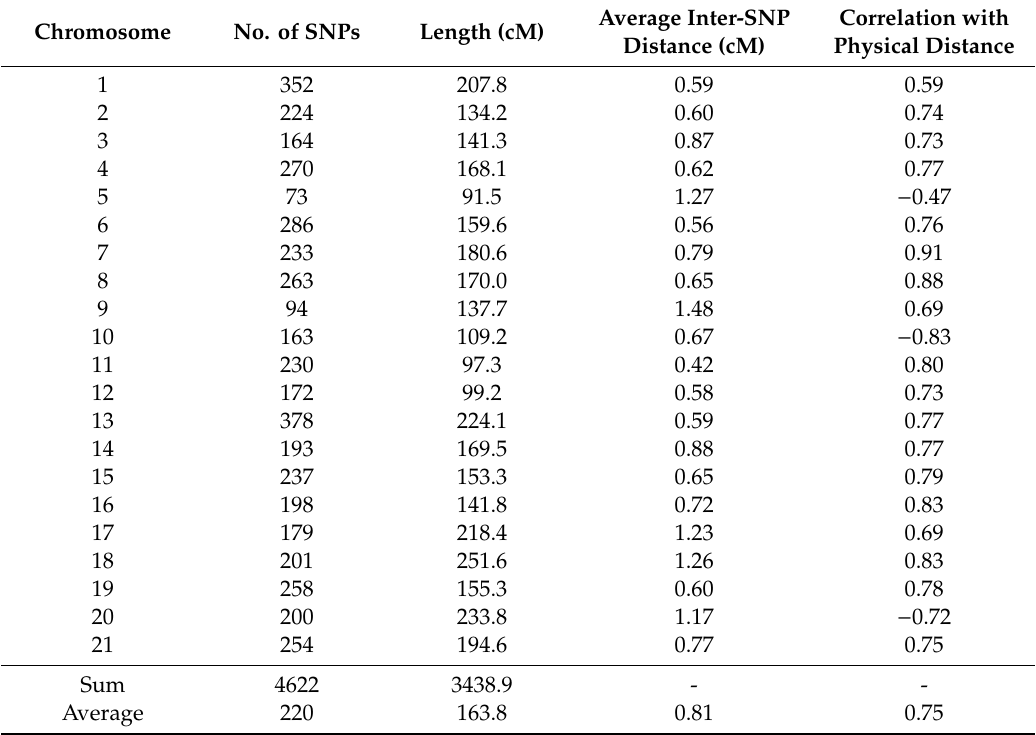
Table 2. SNP marker distribution in 21 linkage groups representing the chromosomes of intermediate wheatgrass (IWG). Marker order consistency is shown by correlation values ( r ) between the linkage maps and physical distances (bp). Negative value indicates a flipped orientation of the linkage map relative to the physical